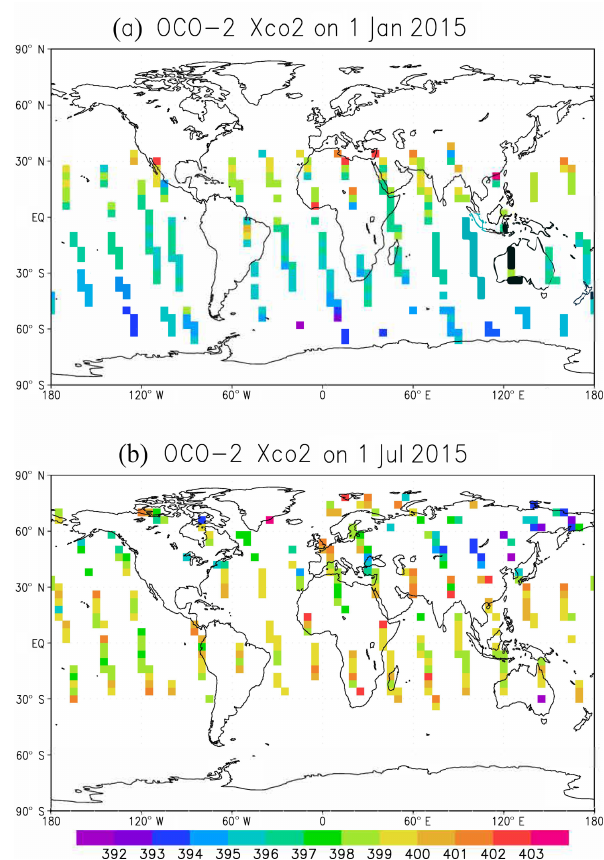
Figure 1. The 10s average of good-quality OCO-2 XCO 2 ob- servations (warning level < = 15), obtained from David Baker for (a) 1 January 2015 and (b) 1 July 2015.